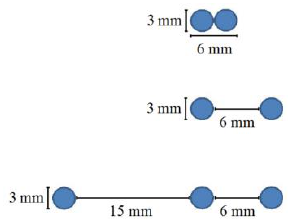
Figure 3. The three array states of 1-D pinhole design that were simulated and tested in the